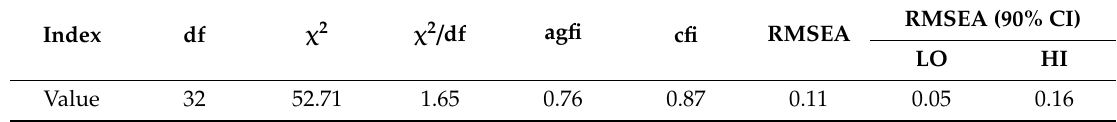
Table A11. Construct validity values of the three scales of the indicator of “system